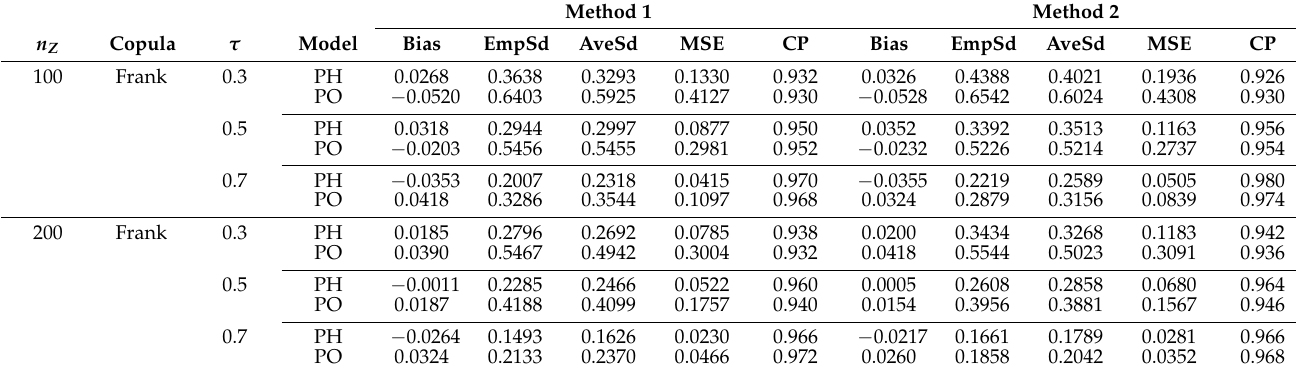
Table 2. The estimators of θ under Case 1 when the variable of interest is Y.